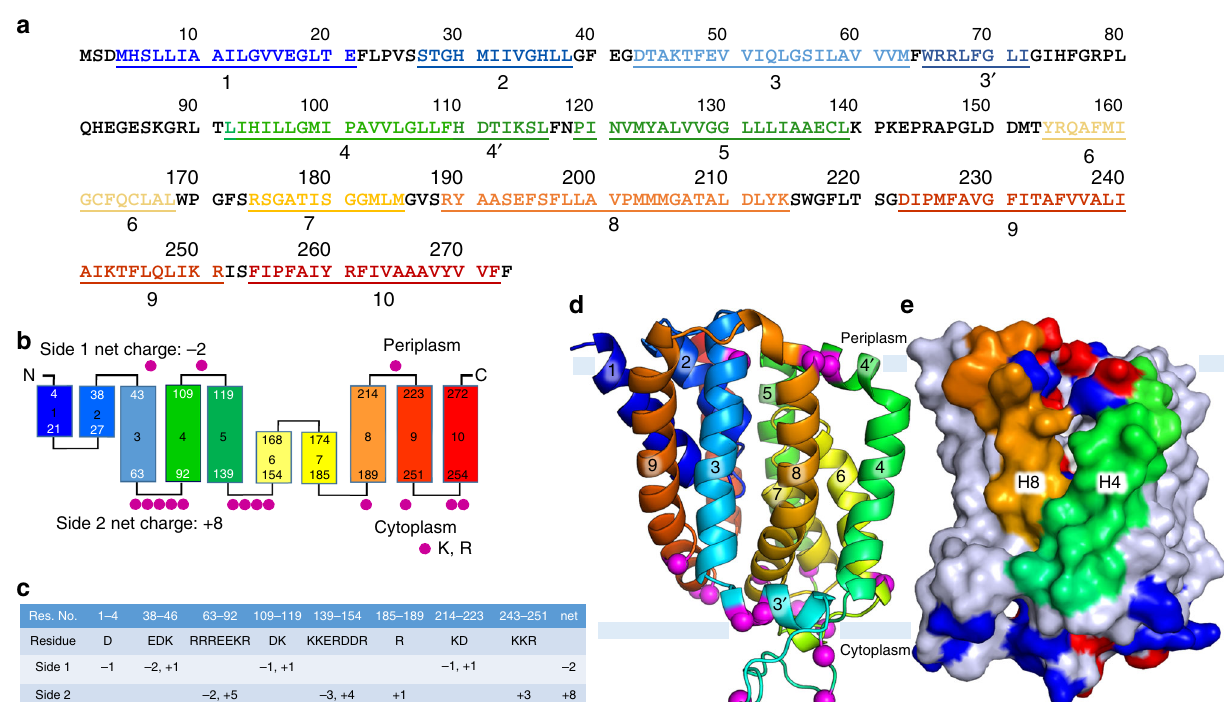
Fig. 5 Positive-inside rule tally for BacA. a Sequence of BacA from E. coli rainbow color coded from N-terminus to C-terminus. Helices observed in the crystal structure are numbered as described in the text. b Distribution of cationic residues arginine and lysine in the periplasmic and cytoplasmic exposed stretches of polypeptide. Arginines and lysines on the cytoplasmic side considerably outnumber those on the periplasmic side of the membrane suggesting the protein is oriented with its N-terminus and C-terminus in the periplasm. c The table enumerates the relevant amino acids on either side of the membrane. d Overall architecture of BacA indicating the cationic residues, as described in b , as magenta spheres. e Surface representation of BacA where cationic (Arg, His, Lys) and anionic (Asp, Glu) residues are colored blue and red, respectively. H4 and H8 are colored green and orange, respectively.